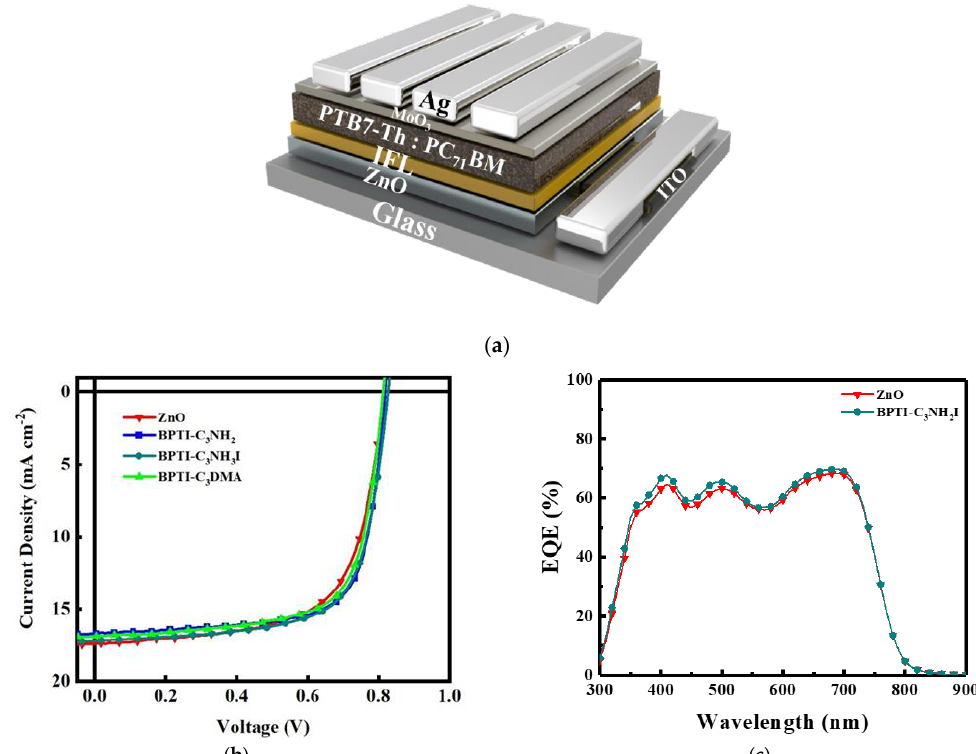
Figure 3. ( a ) Structure, ( b ) J – V curves, and ( c ) EQE spectra of the PSC devices. Table 2. J – V properties of the PSC devices.